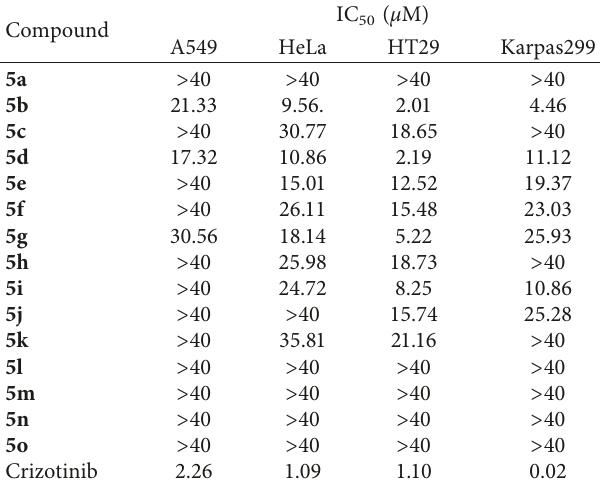
Table 1: IC 50 ( µ M) values of the target compounds.